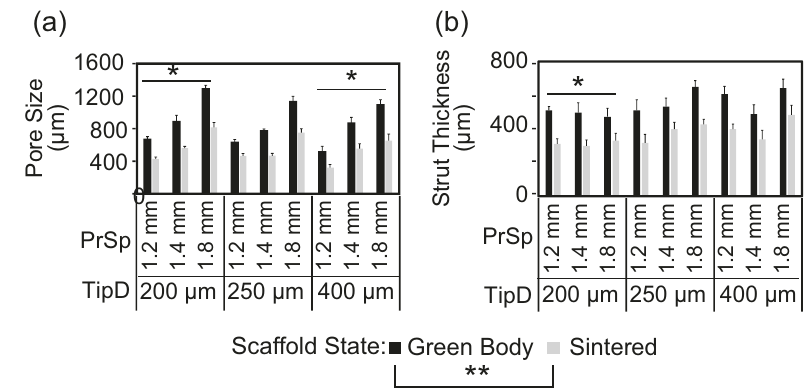
Fig. 5 a Dimensional analysis of average pore size of the nine 3D-printed scaffold architectures tested in the present study. For all architectures, the sintered samples had a signi fi cant (** p < 0.001) reduction in their average pore size. The scaffolds printed using a 200 µm tip diameter showed signi fi cantly (* p < 0.05) greater pore size compared to the scaffolds printed with a 400 µm tip diameter. b Spatial dimensional analysis of strut thickness in the 3D-printed scaffolds. Sintering signi fi cantly (** p < 0.001) reduced the thickness of the struts by ~35%. The struts printed using the 200 µm nozzle were signi fi cantly (* p < 0.05) thinner than those printed using either the 250 or 400 µm tip diameters. PrSp print spacing, TipD tip diameter